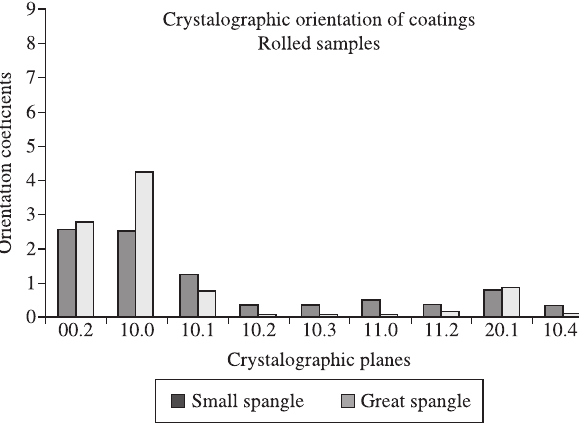
Figure 2. Orientation coefficients of the rolled galvanized samples.